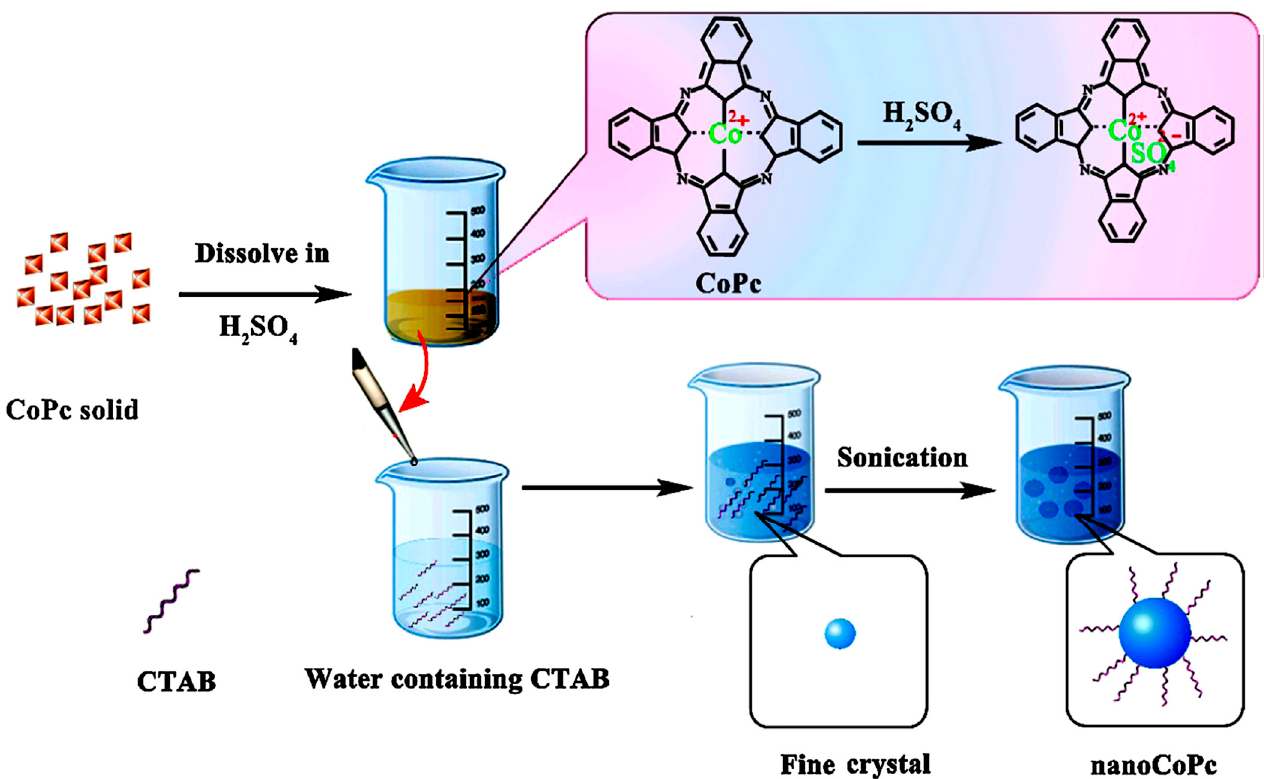
Figure 3. Stepwise preparation of the nanoCoPc-fMWCNTs. Reprinted with permission from ref. [64]. Copyright 2022, Elsevier.